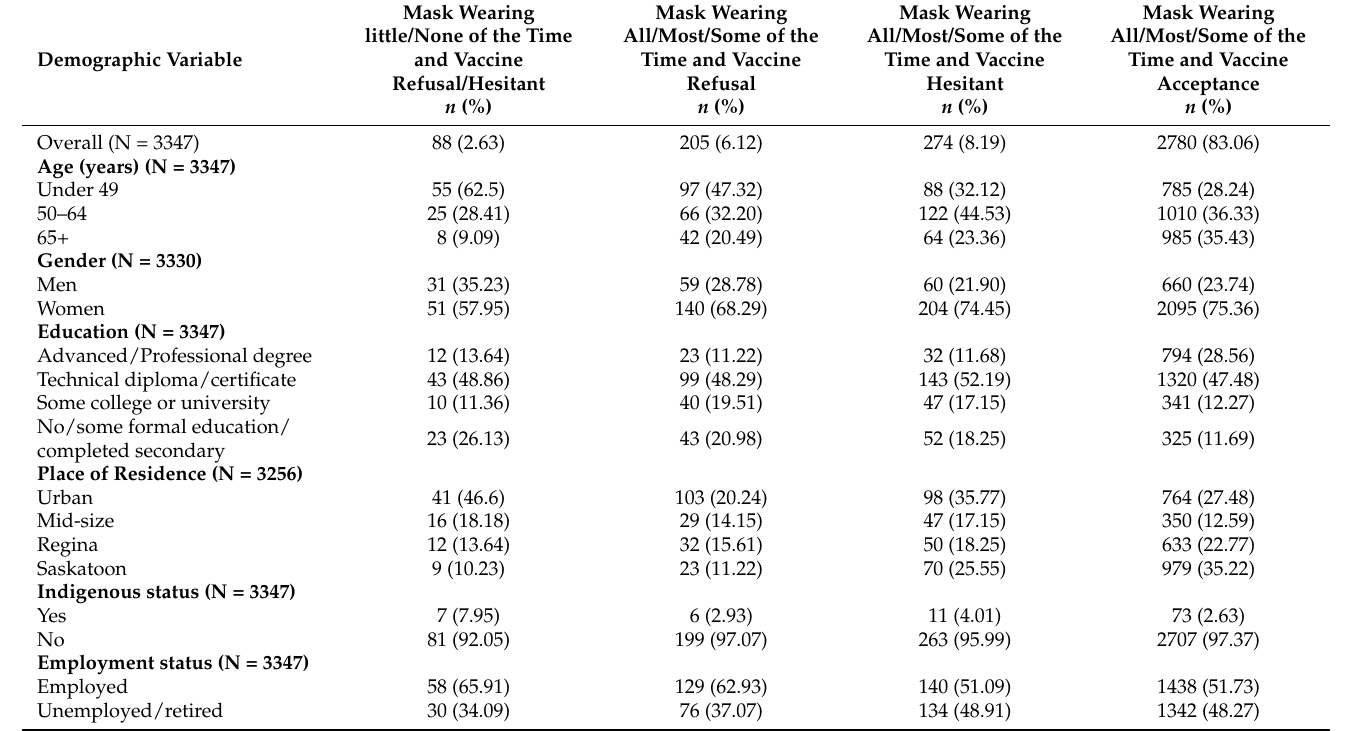
Table 1. Demographic variables by category of the outcome, Saskatchewan, January–May